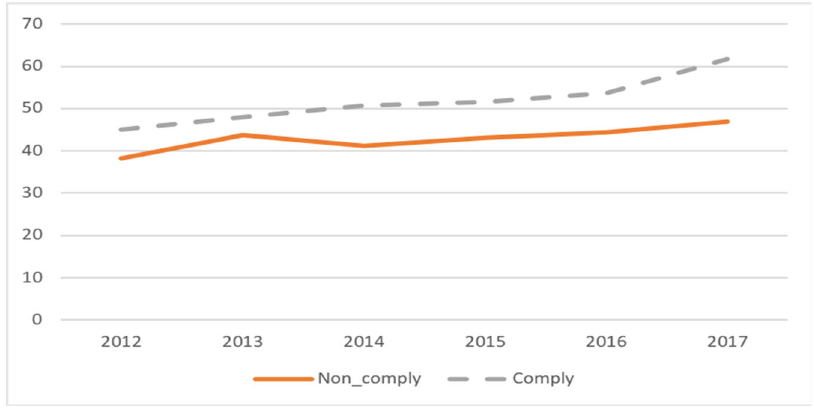
Figure 2. Average executive compensation (million yen) trends Note: Non_comply is mean of companies which appointed two or more independent directors after June 2015 and Comply is mean companies which appointed two or more independent directors before June